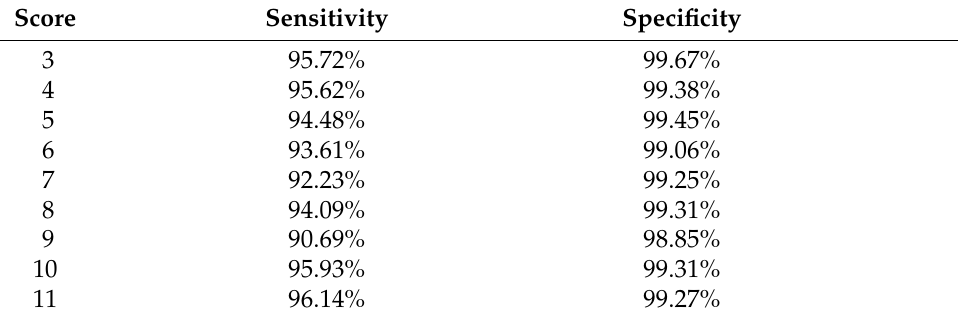
Table 8. The specificity and sensitivity for each considered SPPB score on the test set.